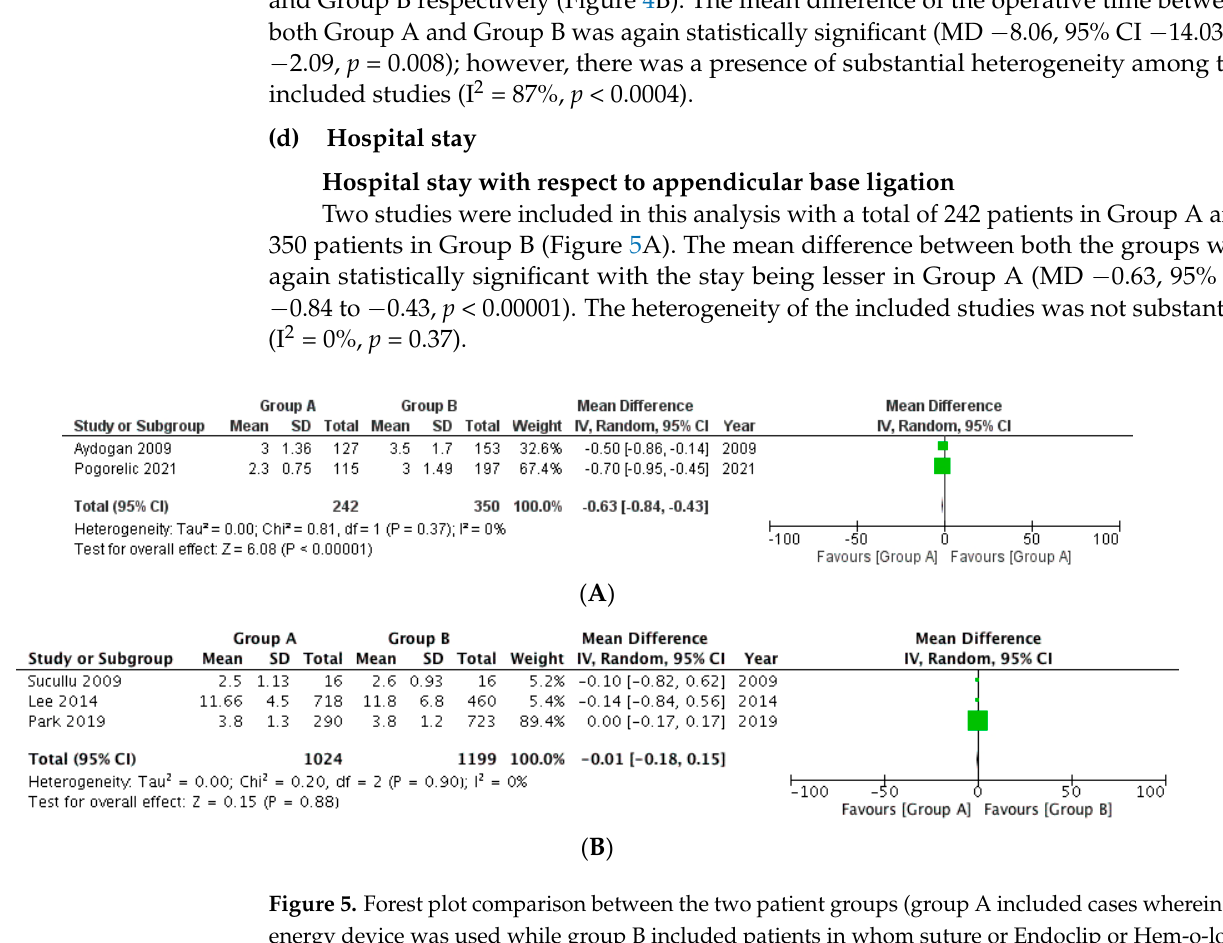
Figure 4. Forest plot comparison between the two patient groups (group A included cases where energy device was used while group B included patients in whom suture or Endoclip or Hem-o- lok ® was used) in terms of the average operative time (minutes). Figure 4A, B depict the outcome comparison with respect to appendicular base ligation and mesoappendix division, respectively.